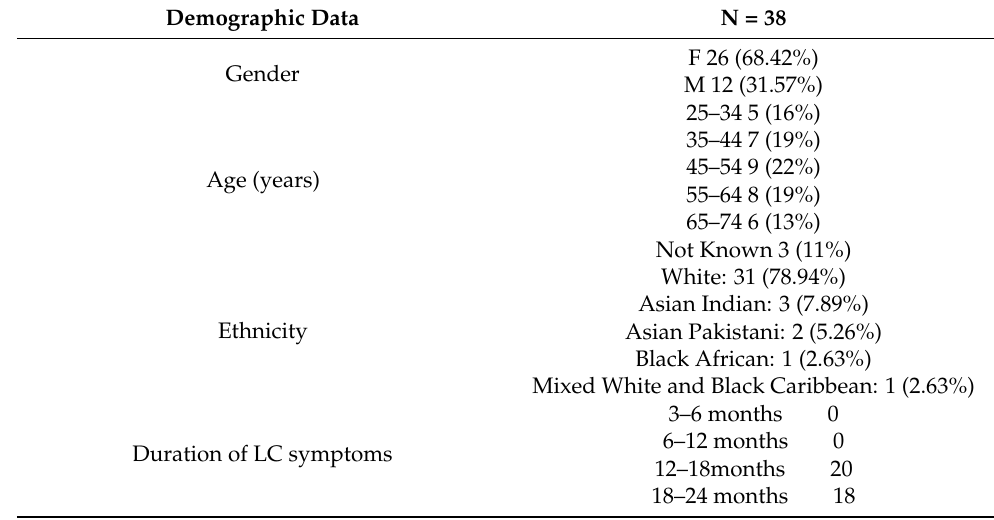
Table 2. Persons with Long COVID (PwLC)